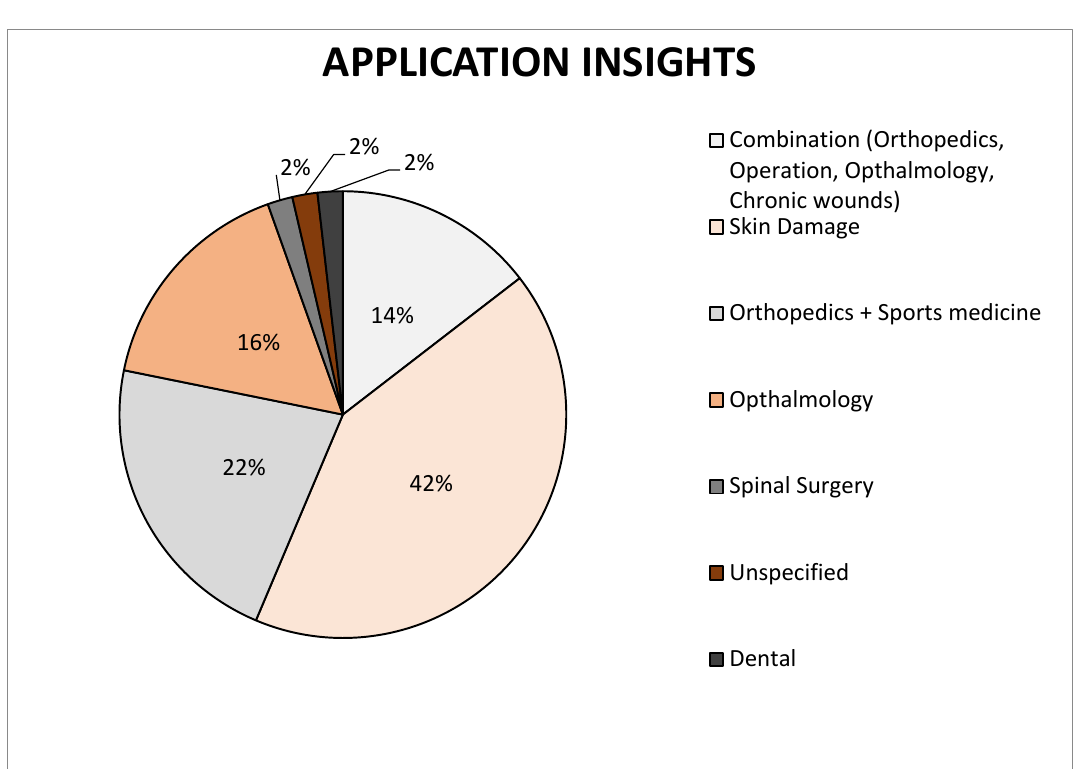
Figure 3. Representation of individual types of amniotic membrane application on the market, data collected from cited